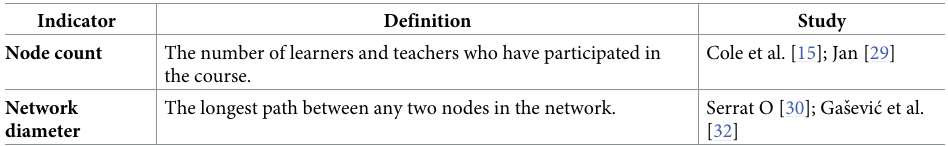
Table 2. Introduction of indicators for Question